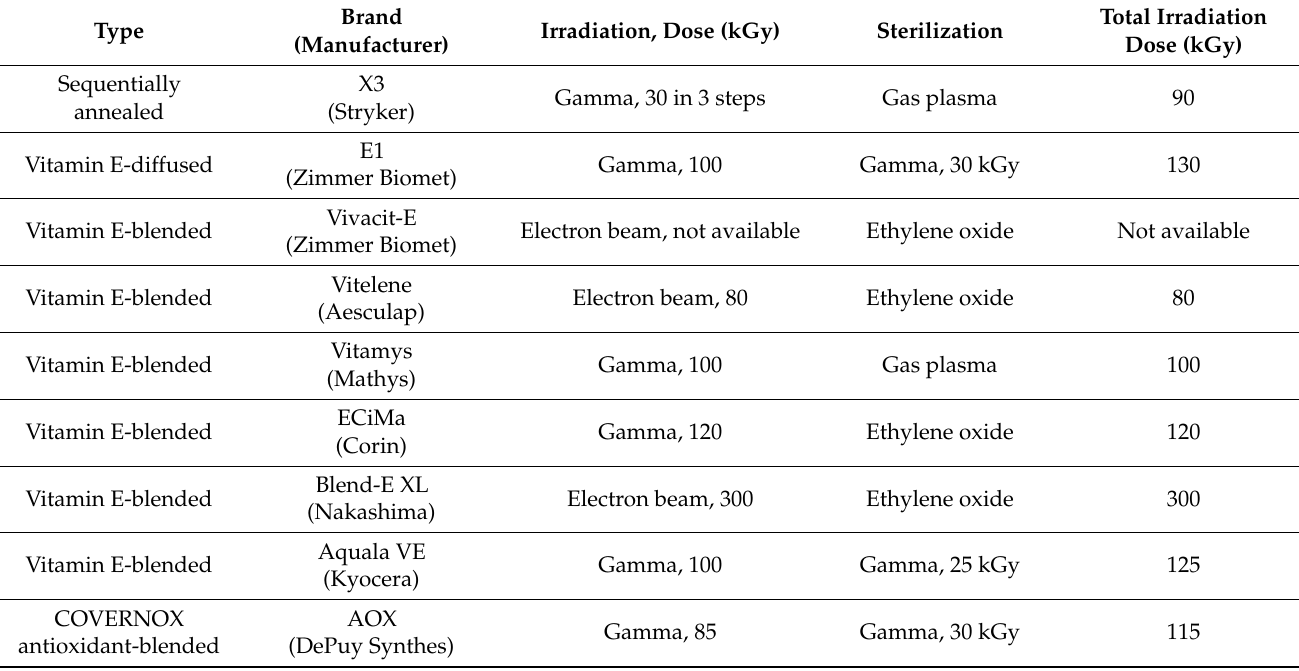
Table 3. Second-generation highly cross linked